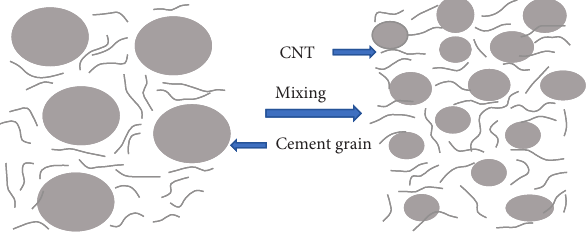
Figure 17: Schematic of the mixing effect on the cement grain size [97].